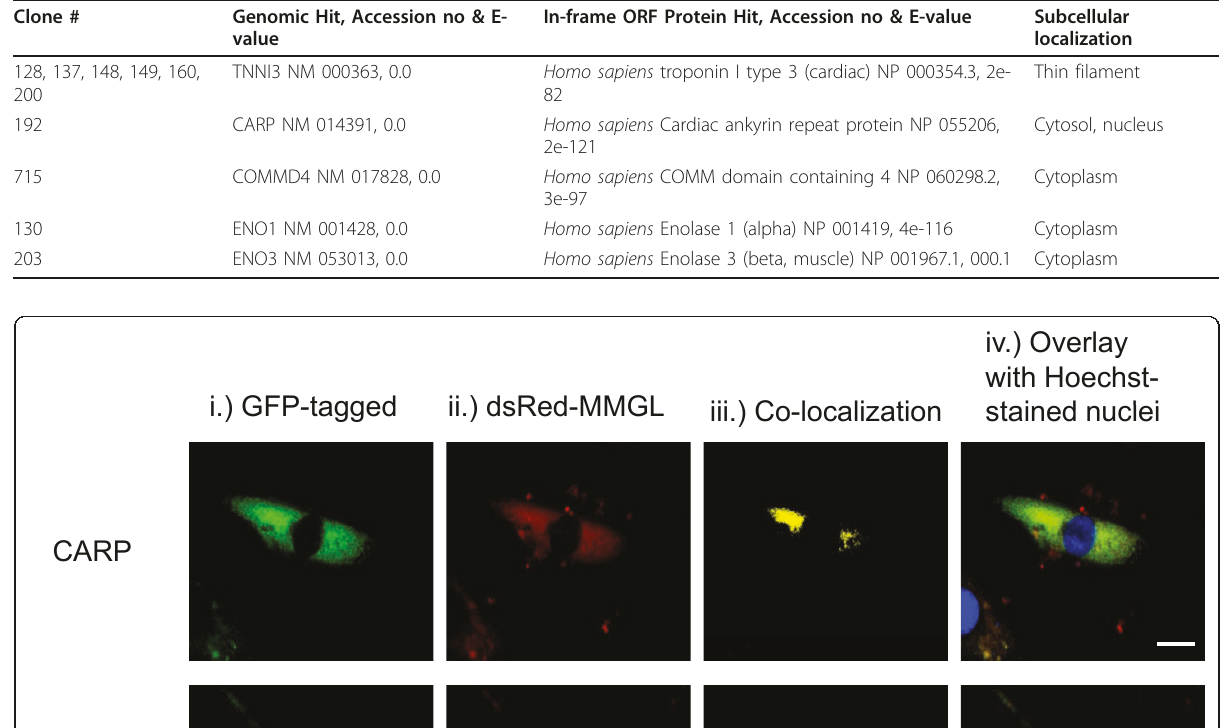
Table 2 Interactors of MMGL isoform 4 identified by yeast 2-hybrid library screening